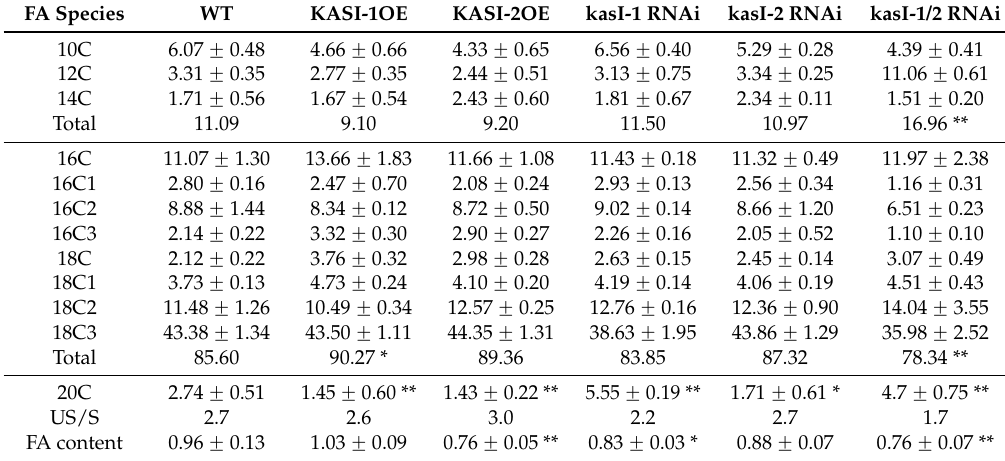
Table 1. Analysis of fatty acid methyl esters (FAME) of the total lipid extract from leaves of wild type (WT) and transgenic tobacco.